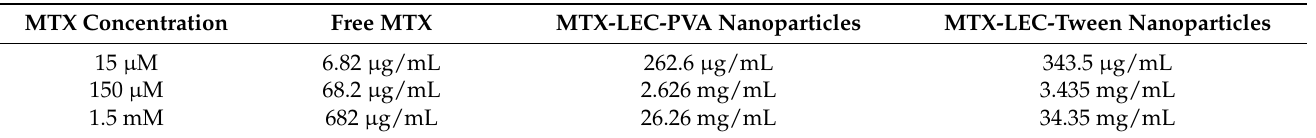
Table 1. Free MTX and nanoparticle amount required per milliliter to obtain the desired drug concentration for each experiment. MTX Concentration